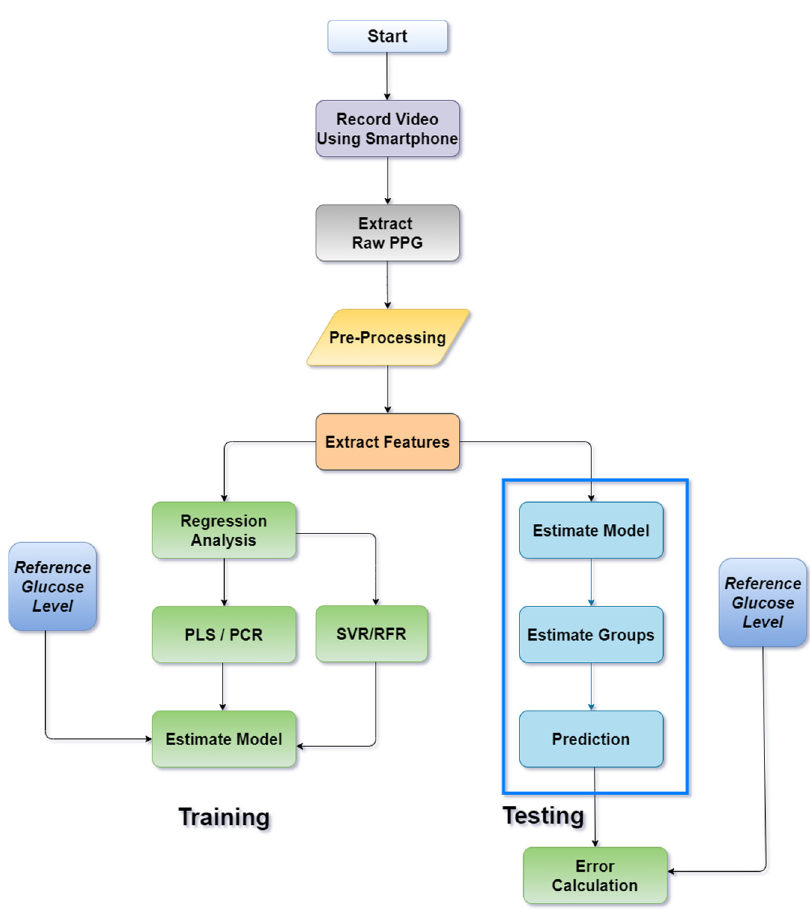
Figure 5. Proposed model for the quantitative analysis of glucose level from smartphone video.